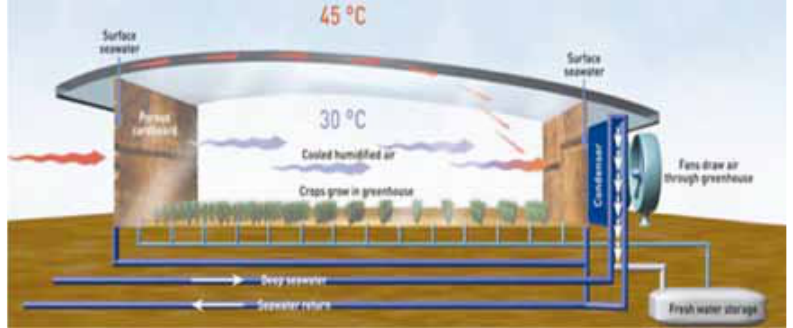
Figure 5 . Illustration of a seawater greenhouse desalination facility source : Seawater Greenhouse Limited,